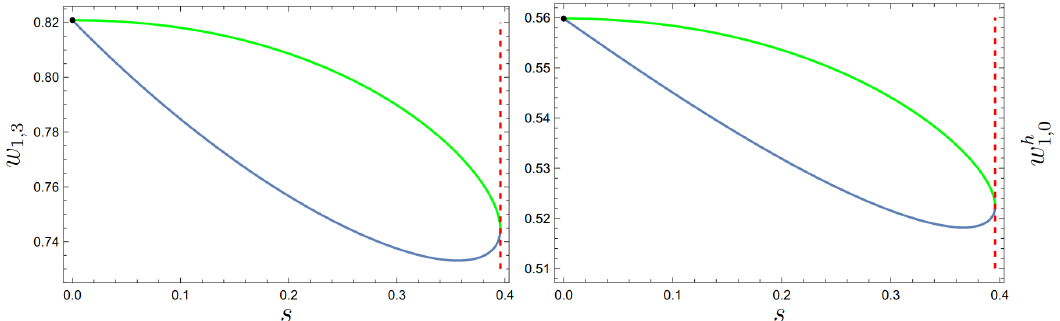
Figure 6 . Coefficients { w 1 , 3 , w h } , see (3.44) and (3.45), of the perturbative conformal order in 1 , 0 b → + ∞ deformation of Model II, with a parameter s characterizing the cubic coupling between the scalars f and g , see (3.43). The black dot indicates s = 0 results reported in appendix A. There are two branches of the conformal order for s < s , represented by the vertical dashed red lines. max Since s 1 , there is no perturbative conformal order in Model max <